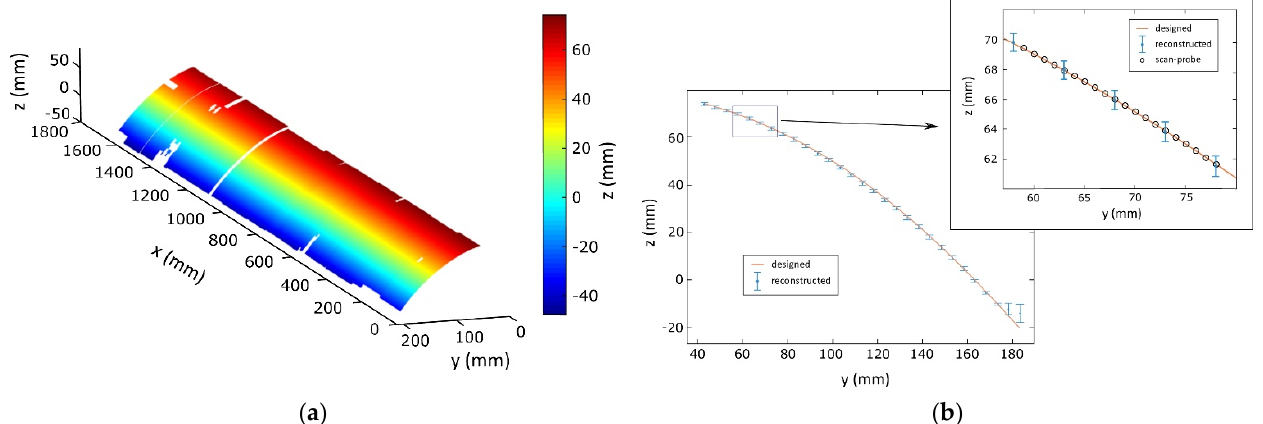
Figure 13. ( a ) 3D map of the reconstruction of the m-PTC performed with laser profilometry. ( b ) The reconstructed parabola (blue dots) with the designed profile (red line). In the expansion is shown a section also reporting the data measured by the contact probe (black circles).